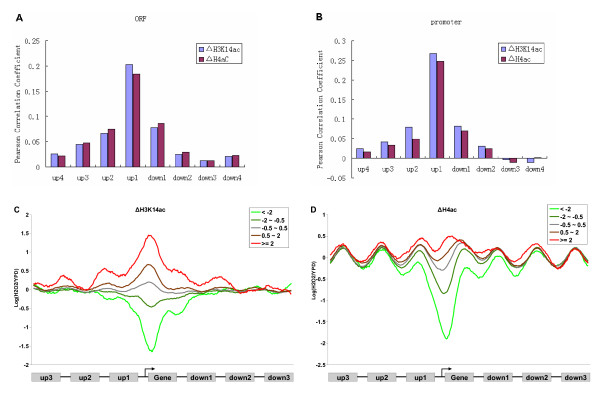
The changes of gene expression correlated with the acetylation change of its neighboring genes. (A) Correlation between change of gene expression and ΔH3K14ac (blue) and ΔH4ac (brown) of its neighbors in the coding regions. up1 ~ up4 means 4 linked genes upstream of the target gene; down1 ~ down4, 4 linked genes downstream. (B) Correlation between change of gene expression and the change of acetylation of its neighbors in promoter regions. (C) Composite profiles of ΔH3K14ac according to the change gene of expression. The genes were assigned to 1 of 5 groups according to their expression change under H2O2-stress conditions. (D) Composite profiles of H4ac change according to the change of expression.